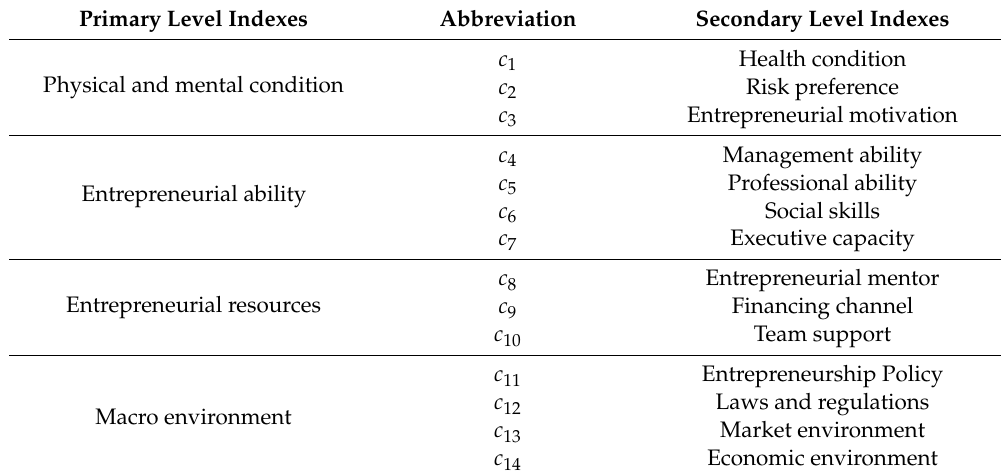
Table 2. Uncertainty tolerance level of the evaluation indexes of entrepreneurs. Primary Level Indexes Abbreviation Secondary Level Indexes c 1 Health Physical and mental condition